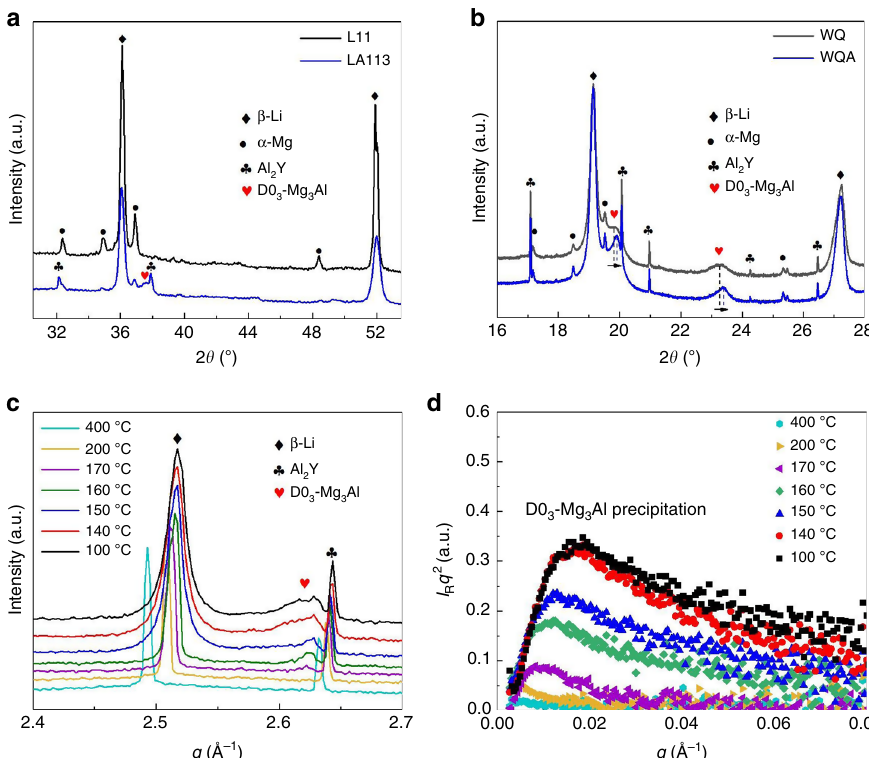
Fig. 3 X-ray diffraction (XRD) pro fi les of L11 and LA113, and in situ X-ray synchrotron data of solution-treated LA113 during air quenching. a Cu K α radiated XRD pro fi les of water-quenched (WQ) L11 and LA113, respectively. b Synchrotron XRD pro fi les of LA113 for the WQ and water-quench-aged (WQA) state, respectively. The 2 θ angle of D0 3 -Mg 3 Al increases on ageing, indicating a decrease in d -spacings. c Wide-angle X-ray scattering (WAXS) pro fi les as a function of measuring temperature during air quenching, where q = 4 π sin θ / λ , θ is half the scattering angle between the incident beam and the scattered beam and λ is the wavelength of the incident X-ray. The scattering peak corresponding to D0 3 -Mg 3 Al becomes visible at 170 °C with its intensity increasing during cooling to 140 °C. The peak shifts on cooling is induced by lattice thermal contraction. d Selected Kratky plots ( I R q 2 vs q ) of the small- angle X-ray scattering (SAXS) data as a function of temperature on cooling, where I R = ( I T − I 0 )/ I 0 is the relative change of the SAXS scattering intensity, I T the scattering intensity at a given temperature T and I 0 is the initial scattering intensity at 400 °C. The scattering from the D0 3 -Mg 3 Al phase fi rst appears at 170 °C and increases to 140 °C, which matches closely with the WAXS results in the matrix. The inverse fast Fourier transform (IFFT) pattern of the region marked by the yellow square in Fig. 4a is shown in Fig. 4b, revealing the periodic atomic columns of ordered D0 3 - Mg 3 Al (red dots) and the matrix (blue dots). The precipitate/ matrix interface (white dashed line) is mediated by a mismatch dislocation (white). This interfacial dislocation is caused by the modest lattice mismatch between phases, calculated to be 3.3% using δ = ( a β − a D03 /2)/ a β , where a β and a D03 are the lattice parameters of the matrix and D0 3 -Mg 3 Al, respectively. The value of δ and the observed interfacial dislocation indicates that the D0 3 -Mg 3 Al precipitates are semi-coherent with the BCC β - matrix. In general, lattice mismatch can create a certain degree of lattice distortion at the precipitate/ matrix interface, causing a